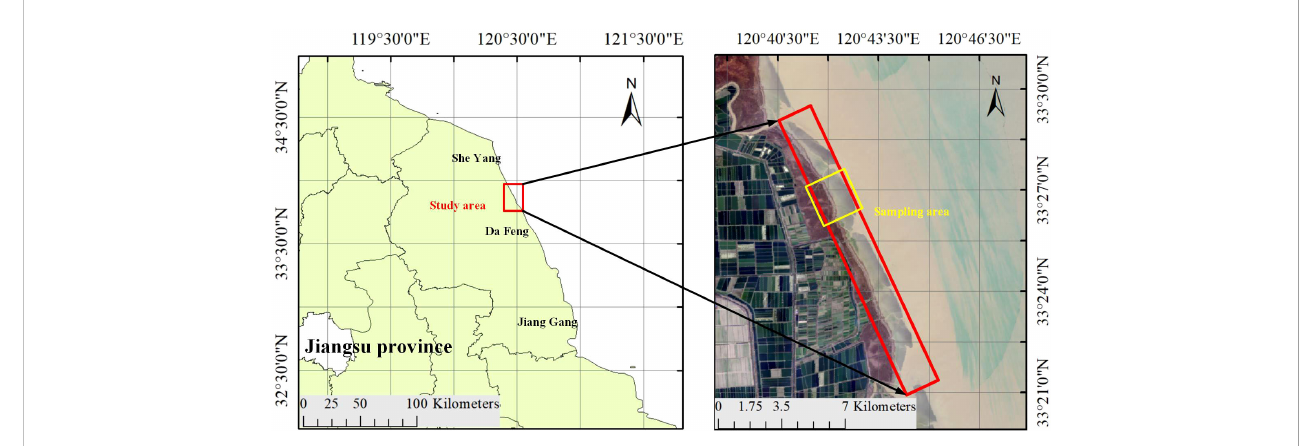
FIGURE 1 Monitoring and Study Area of Sediment Grain Size